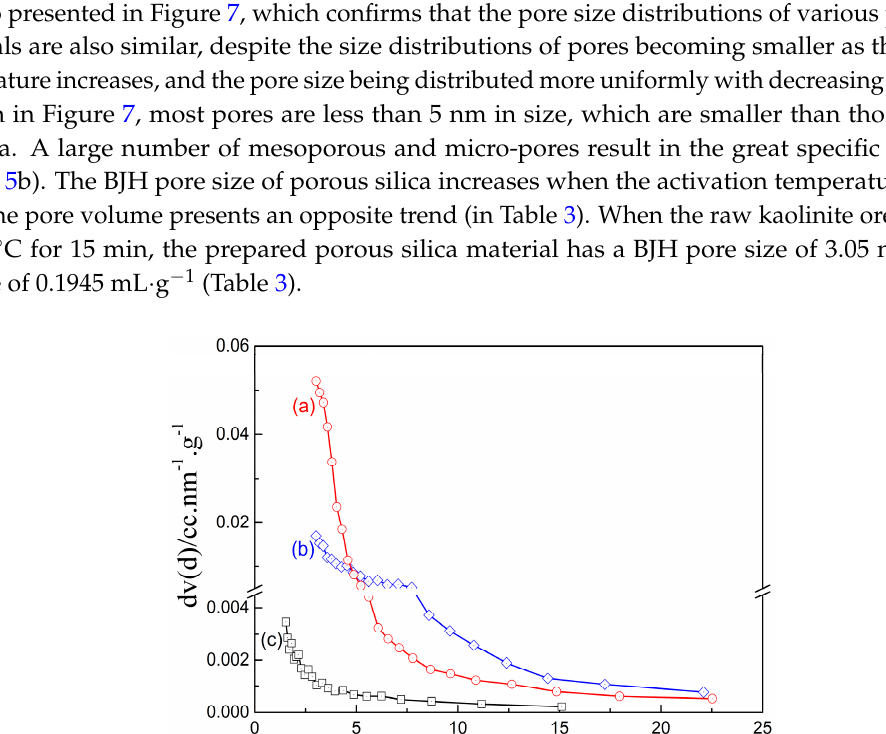
Figure 7. BJH pore size distributions of porous silica (porous silica prepared via acid leaching of kaolinite activated at ( a ) 975 °C; ( b ) 850 °C and ( c ) 600 °C, for 15 min.